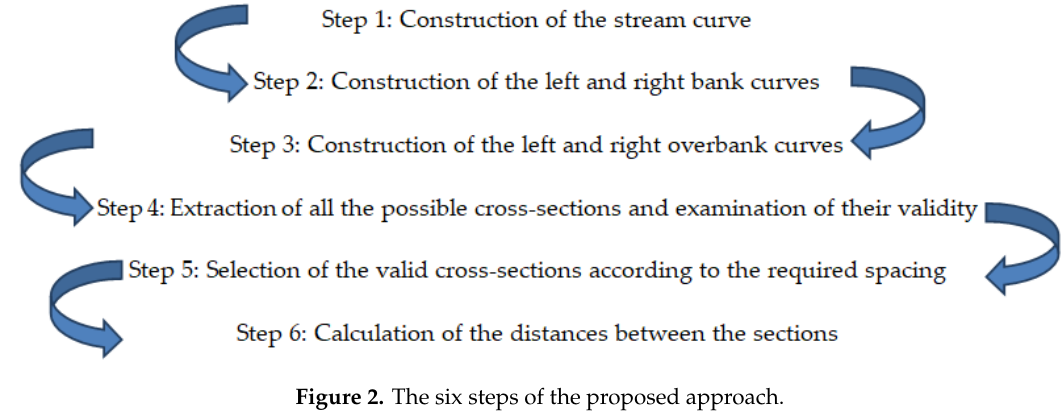
Figure 2. The six steps of the proposed approach.